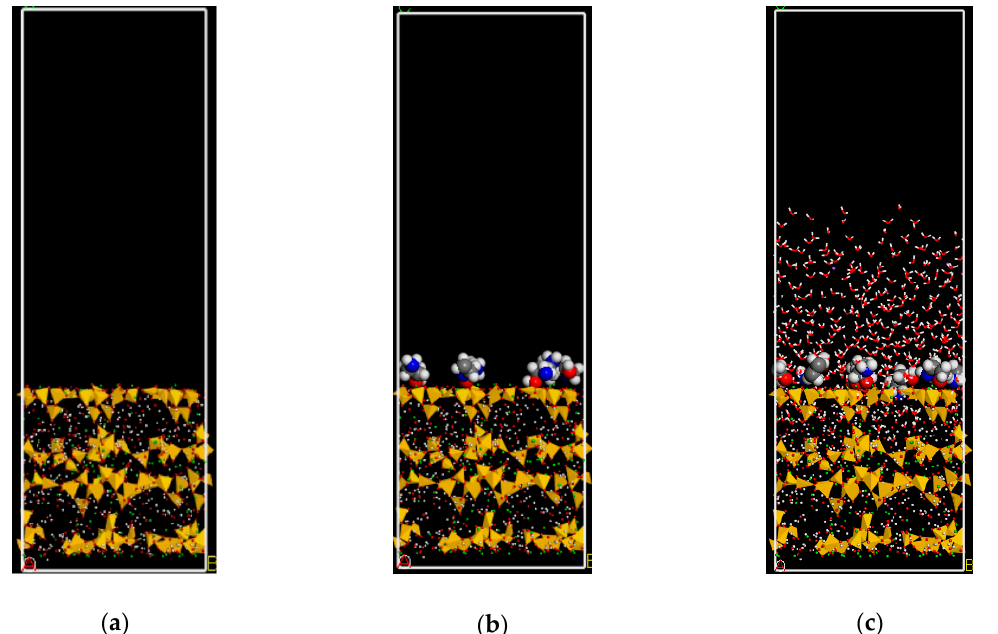
Figure 2. Snapshots for the surface adsorption test (red ball: oxygen atom; green ball: calcium atom; white ball: hydrogen atom; yellow tetrahedral: silicate tetrahedral; violet ball: sodium atom; blue ball: nitrogen atom and grey ball: carbon atom): ( a ) C-S-H surface. Cell parameters: a = 18.37 Å, b = 26.48 Å, c = 78.72 Å, α , β , γ , equal to 90 ◦ ; ( b ) GCMC adsorbents placed and ( c ) final balancing snapshots.